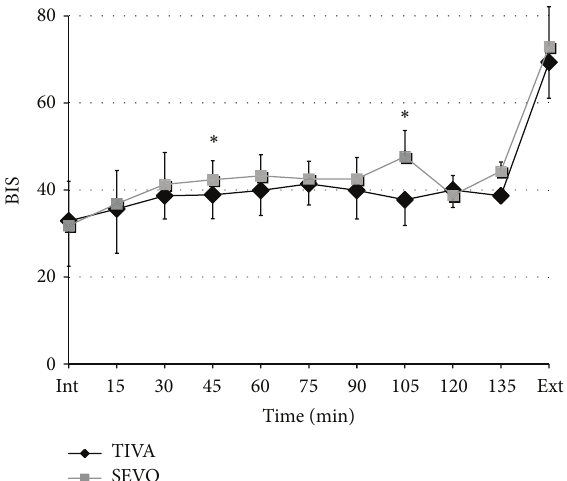
Figure 4: BIS values during surgery in patients receiving sevoflu- rane (gray square) or propofol (black diamond) (mean and SD). ∗ 𝑃 < 0.05 SEVO group versus TIVA group. BIS = bispectral index.